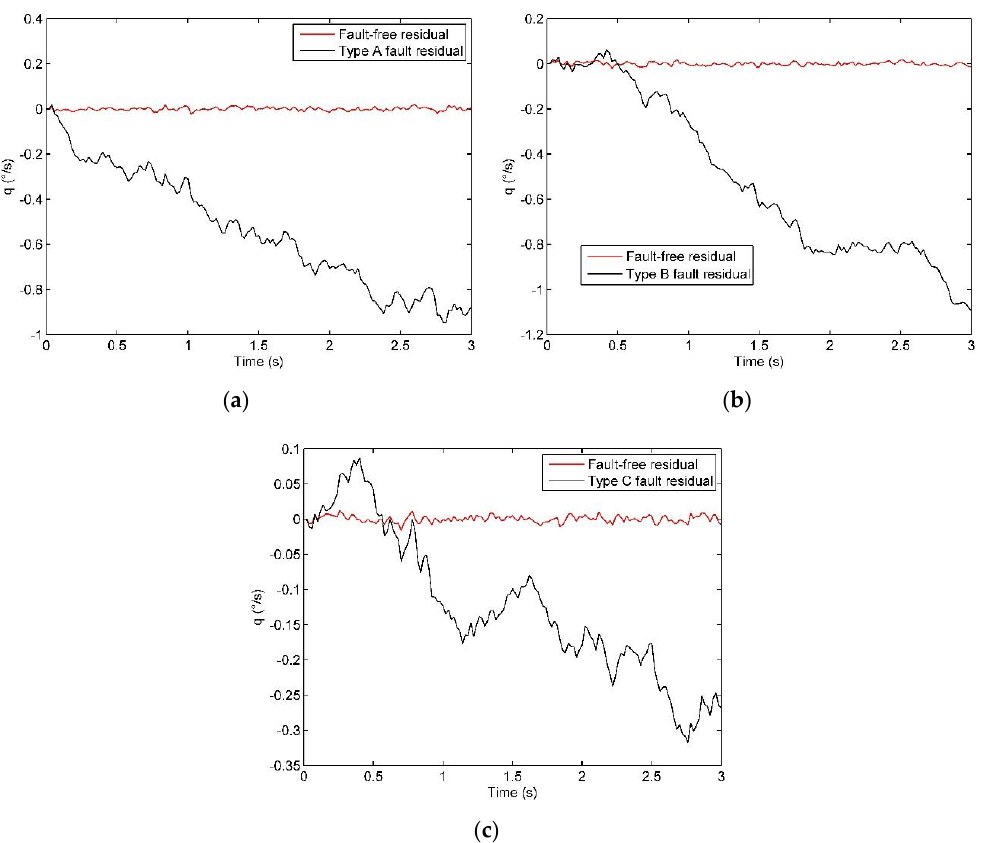
Figure 10. Type A, B, and C fault residuals vs. fault-free residuals: ( a ) type A fault residuals vs. fault-free residuals; ( b ) type B fault residuals vs. fault-free residuals; ( c ) type C fault residuals vs. fault-free residuals. Table 1. Thruster fault detection.